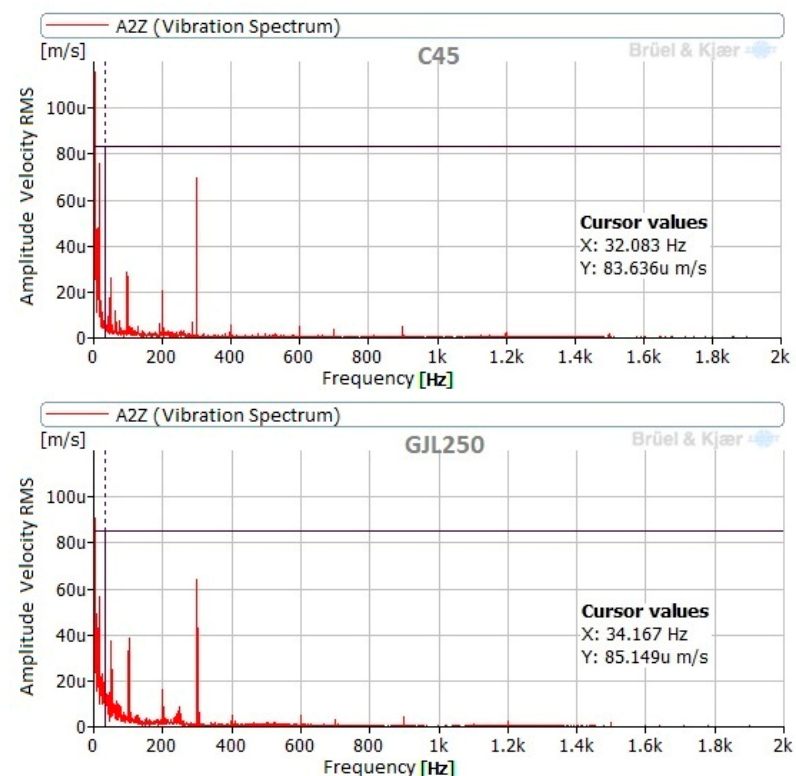
Figure 7. FRF obtained at P1 with impact at I1, with a load of 270 N.